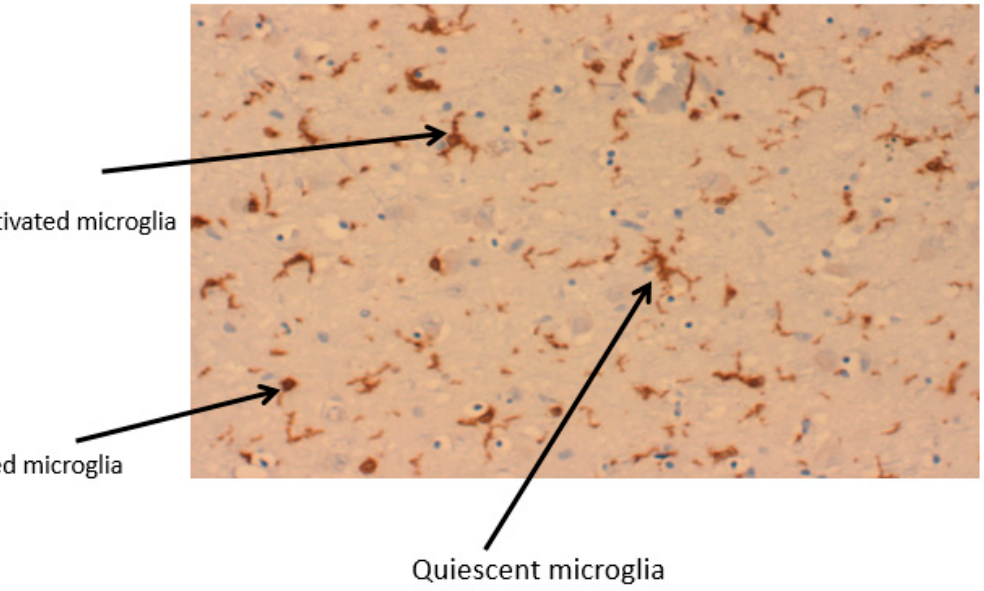
Figure 3. Stages of microglia activation from a ramified structure to an amoeboid form. A section of a Parkinson’s brain, of the region, substantia nigra showing 3 different stages of microglia activation. IbA staining.